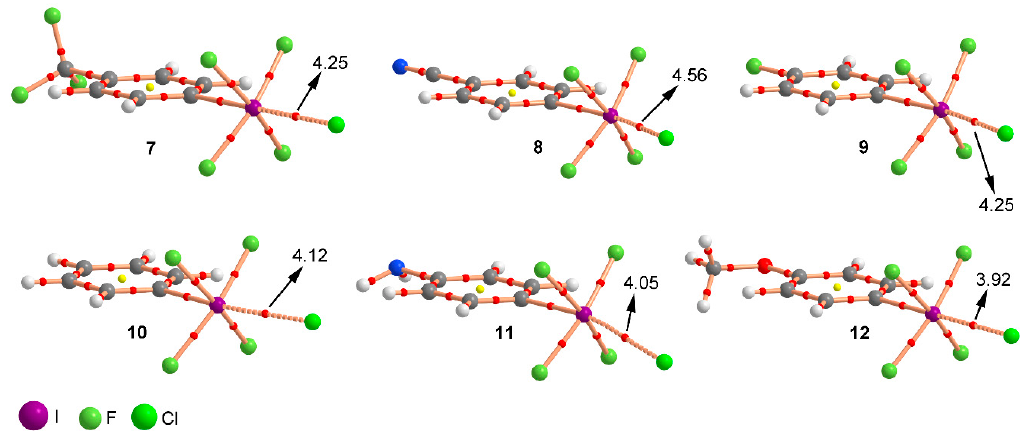
Figure 5. Distribution of critical points (red spheres) and bond paths for Complexes 7 to 12 at the RI-MP2/def2-TZVP level of theory. Bond and ring CPs are represented by red and yellow spheres, respectively. The values of the charge density (10 2 x ρ ) at the bond critical points that emerge upon complexation are indicated in a.u.